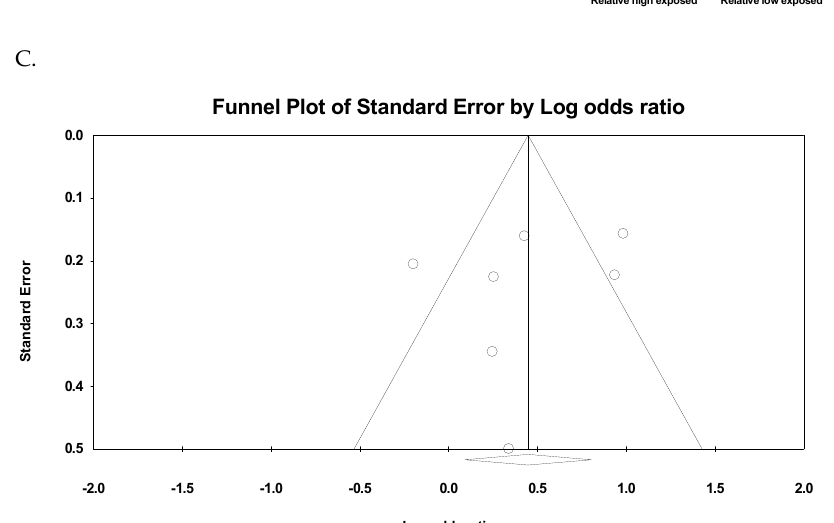
Figure 2. Meta-analysis of childhood obesity by exposed group. ( A ) Forest plot of seven data on the risk of childhood obesity by exposed group. ( B ) Forest plot of six data, except one pilot study on the risk of childhood obesity by exposed group. ( C ) Funnel study in the meta-analysis on the association between BPA exposure and childhood